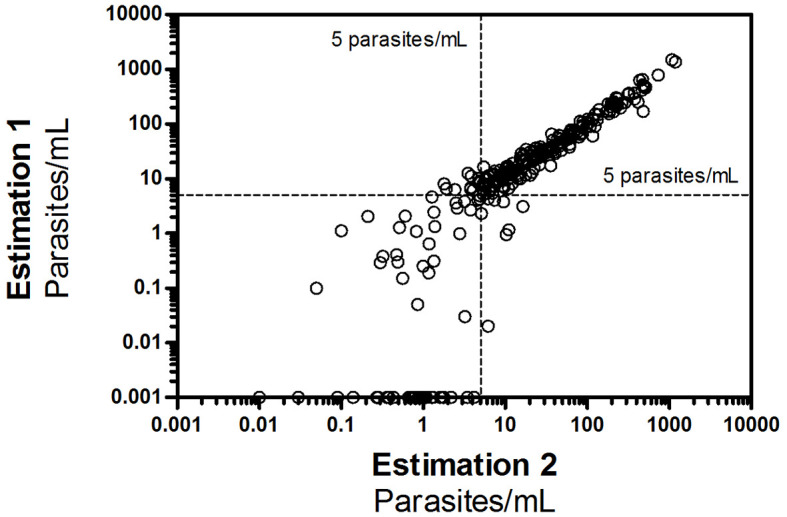
Correlation of duplo Pfs25 qRT-PCR measurements in all study samples.All duplo- estimation data points of the study participants as measured by Pfs25 qRT PCR. All samples with ≥5 parasites/mL were duplo positive (190/190, 100%), and showed a correlation coefficient R2 of 0.94. Variation of samples < 5 parasites/mL was considerably larger and positivity could not be reliably estimated with 35/75 (47%) of samples that were positive in at least one qRT-PCR being single positives (R2 of 0.46).